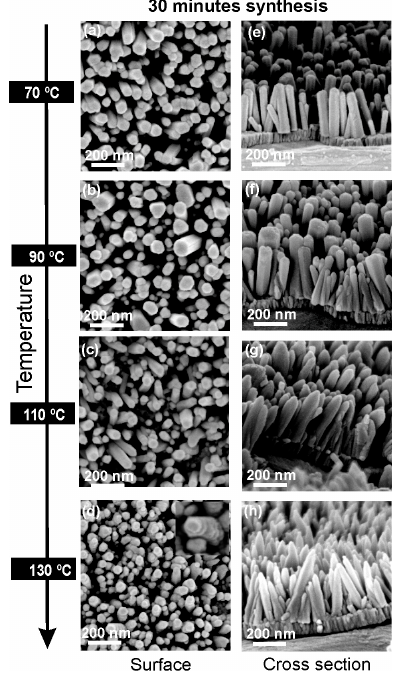
Figure 2. Surface and cross-section scanning electron microscopy (SEM) images of ZnO nanorods produced by hydrothermal method assisted by microwave radiation for 30 min, with different synthesis temperatures on cardboard substrate: ( a , e ) 70 °C; ( b , f ) 90 °C; ( c , g ) 110 °C; ( d , h ) 130 °C.